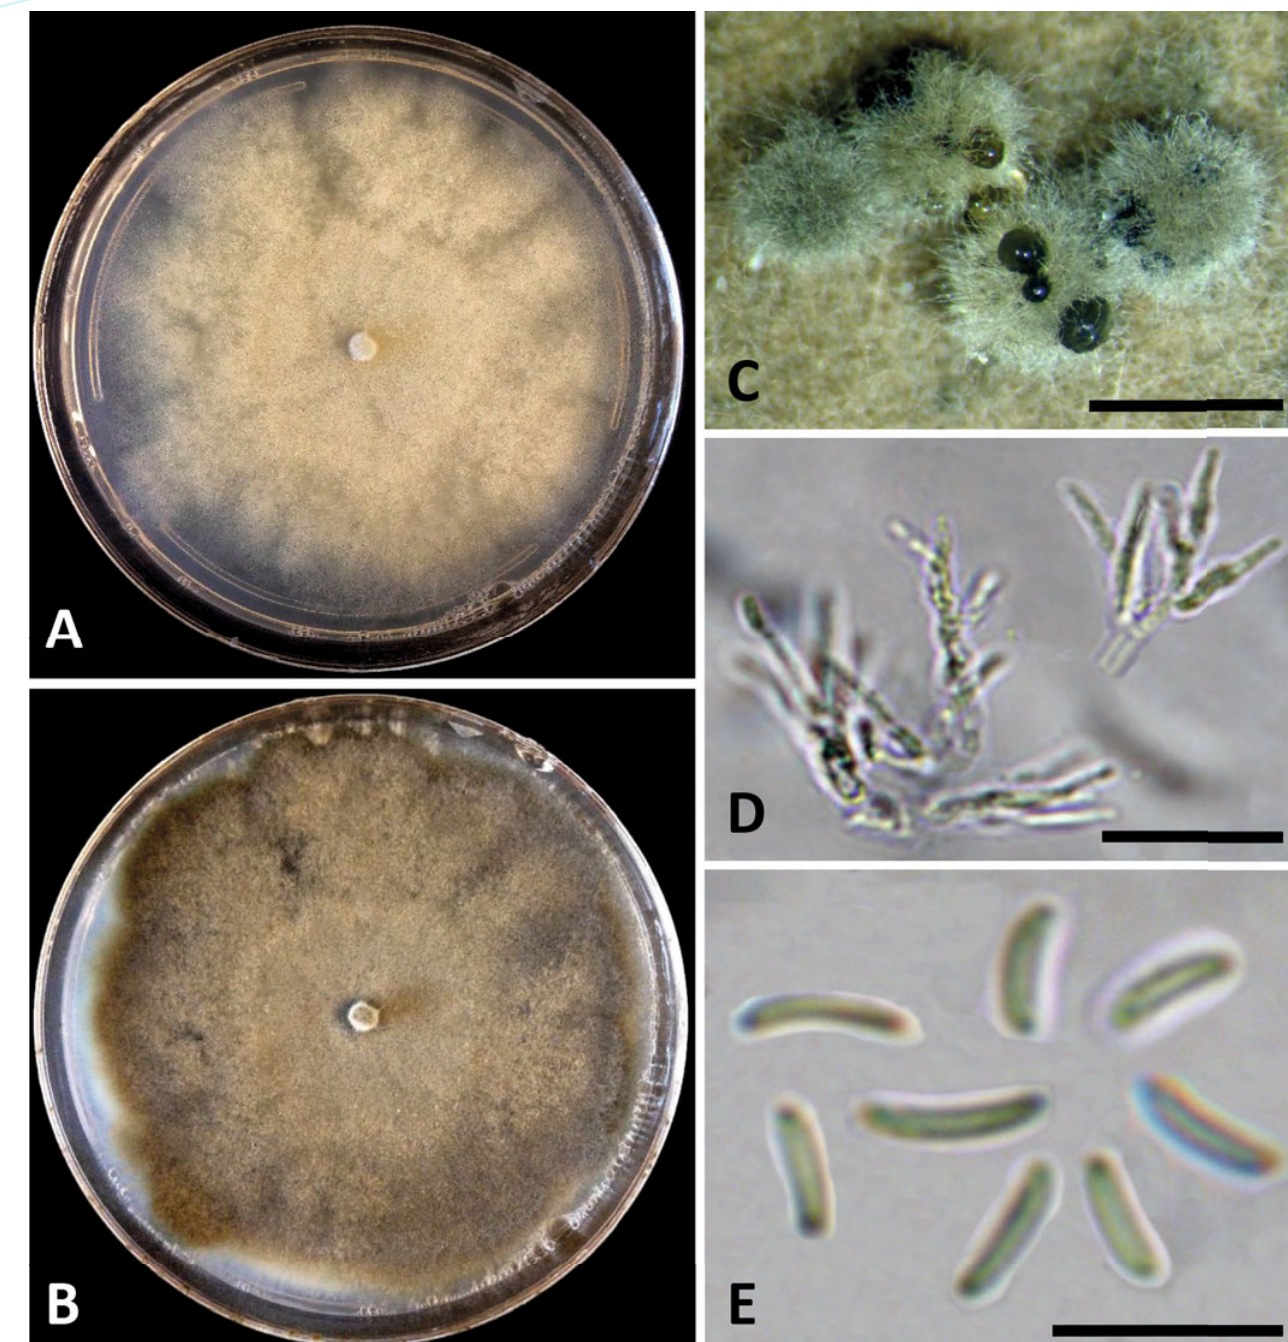
Fig. 19. Cytospora sorbicola (CBS 144245). A. Seven-day-old PDA culture. B. Fourteen-day-old PDA culture. C. Pycnidia. D. Conidiophores and (cid:20)(cid:23)(cid:9)(cid:6)(cid:13)(cid:17)(cid:8)(cid:4)(cid:5)(cid:7)(cid:2)(cid:19)(cid:4)(cid:17)(cid:11)(cid:21)(cid:11)(cid:4)(cid:25)(cid:13)(cid:17)(cid:4)(cid:5)(cid:7)(cid:2)(cid:19)(cid:13)(cid:23)(cid:23)(cid:7)(cid:28)(cid:2) E. Conidia. Bars C = 1 mm; D = 20 μm; E = 5